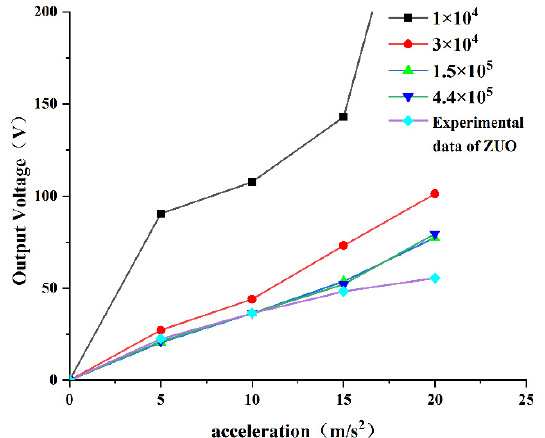
Figure 5. Voltage-acceleration diagram.